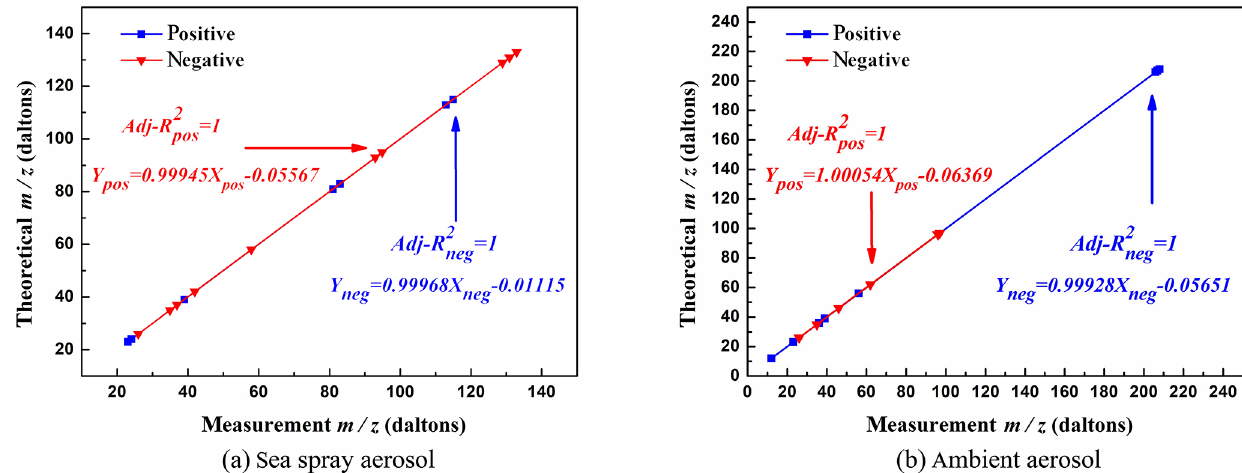
Figure 2. Linear calibration with reference ion